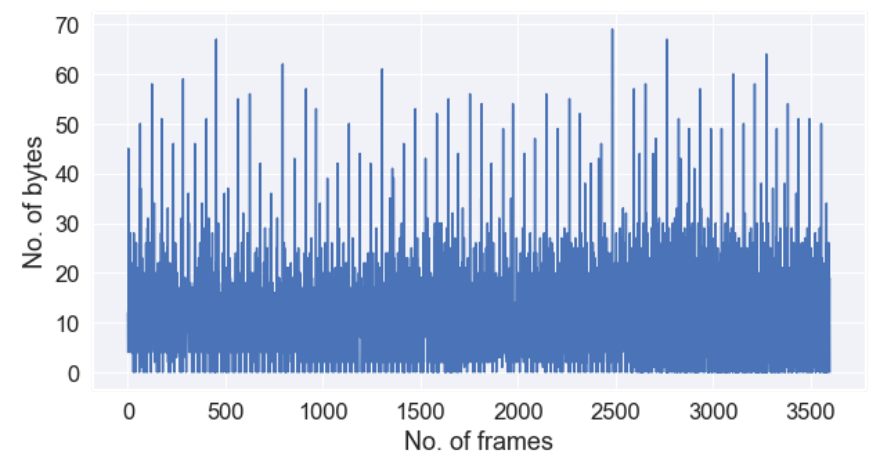
Figure 20b. I/O write requests S2.2.